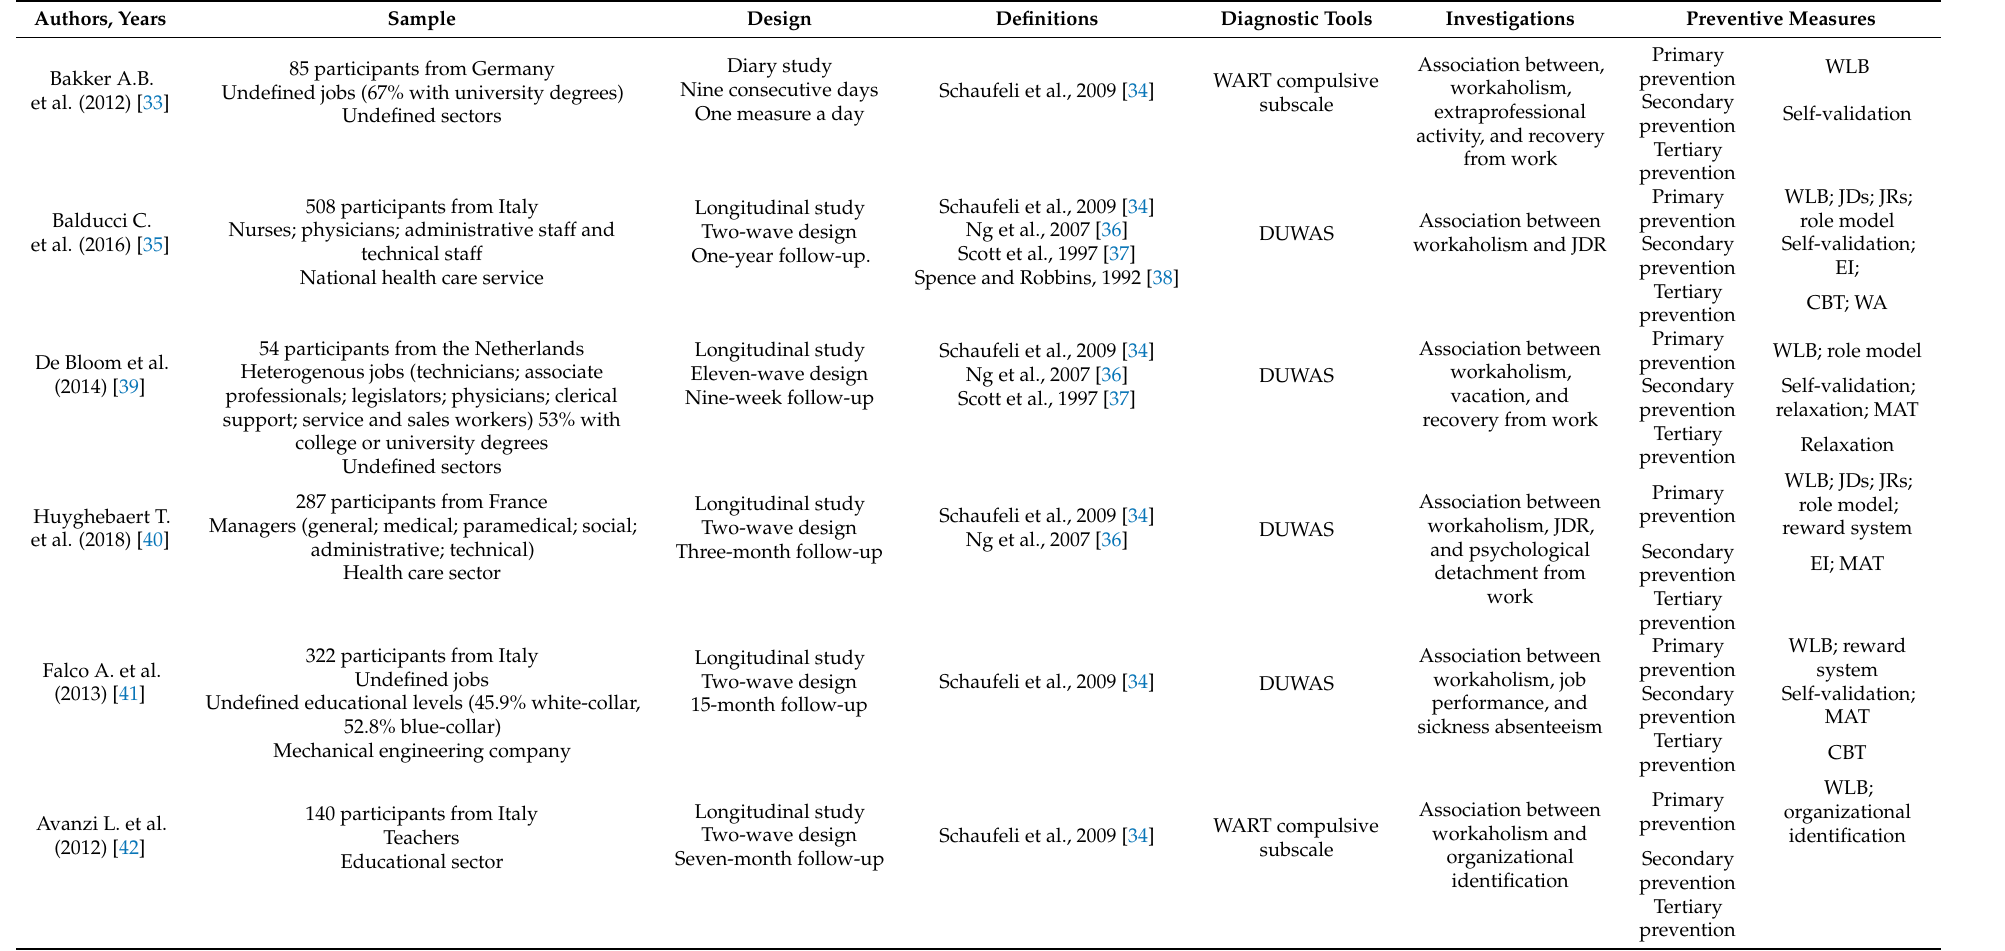
Table 1. Study designs, sample characteristics, evaluation criteria, and main findings of the